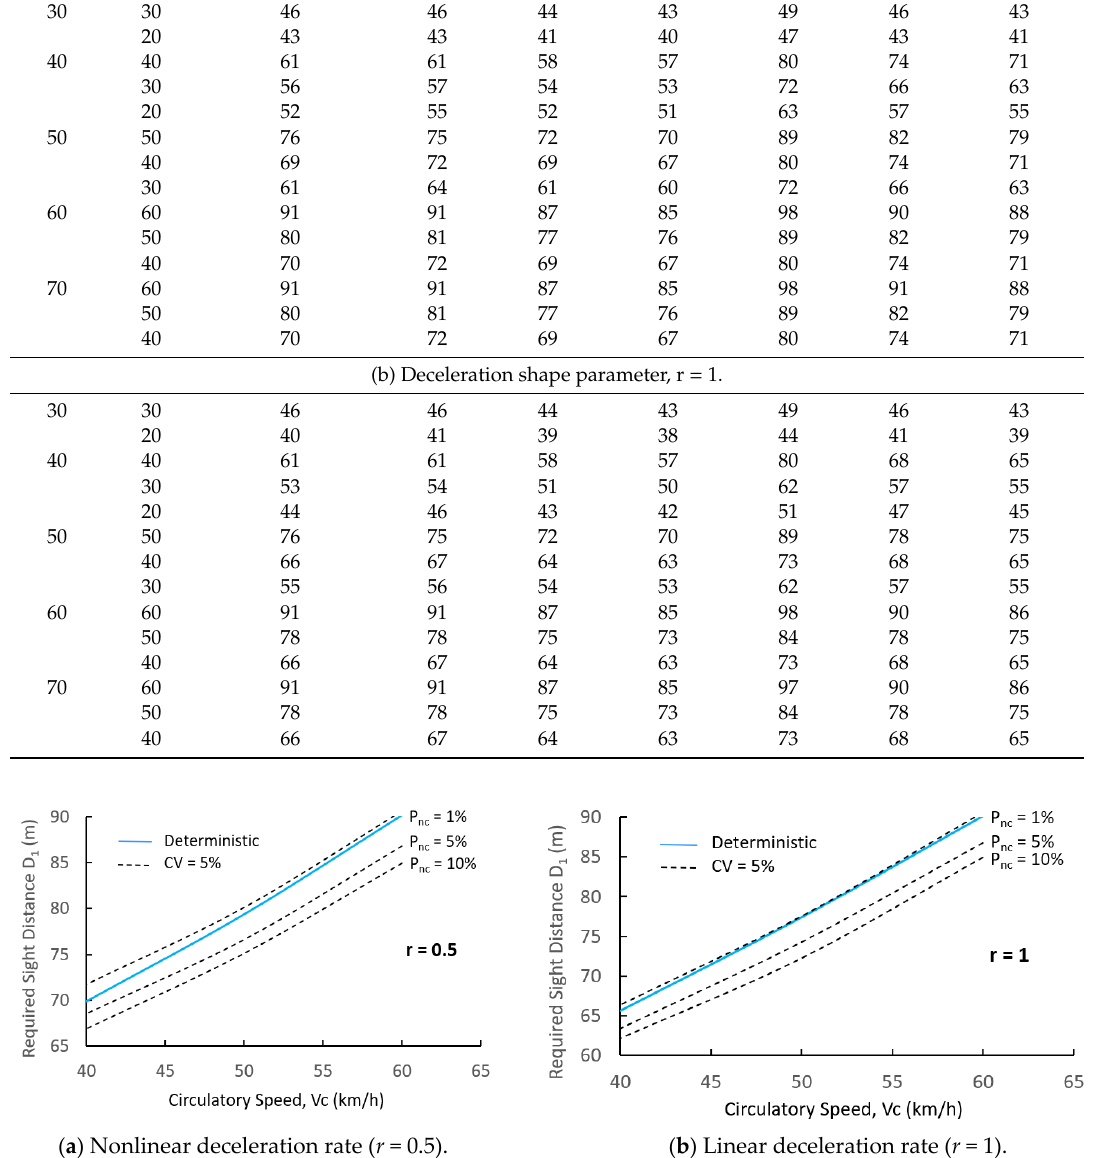
(a) Deceleration Shape Parameter, r = 0.5